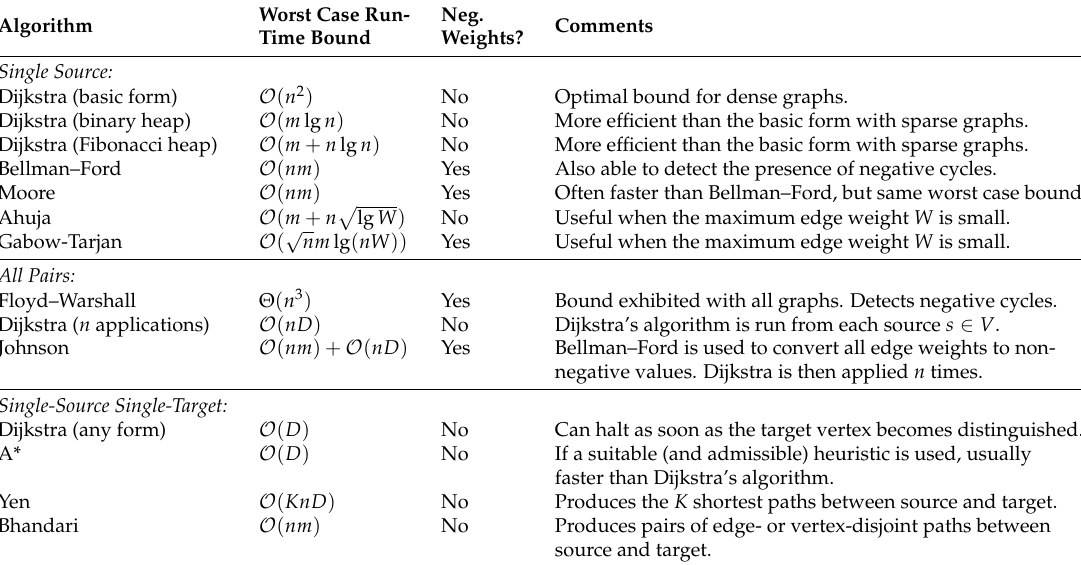
Table 1. Review summary of shortest path algorithms for edge-weighted graphs. Here, D represents the worst case run time bound of the chosen variant of Dijkstra’s